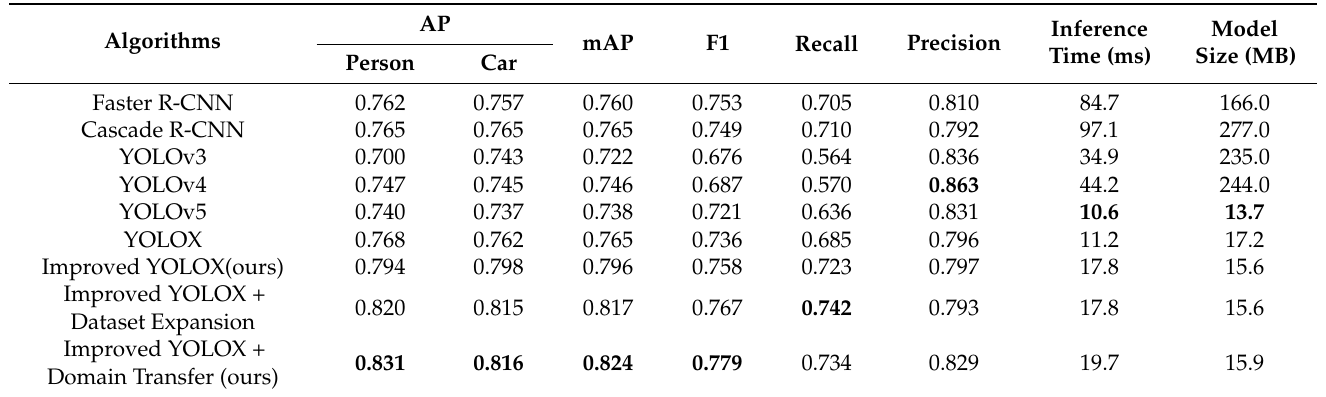
Table 4. Performance comparison of different